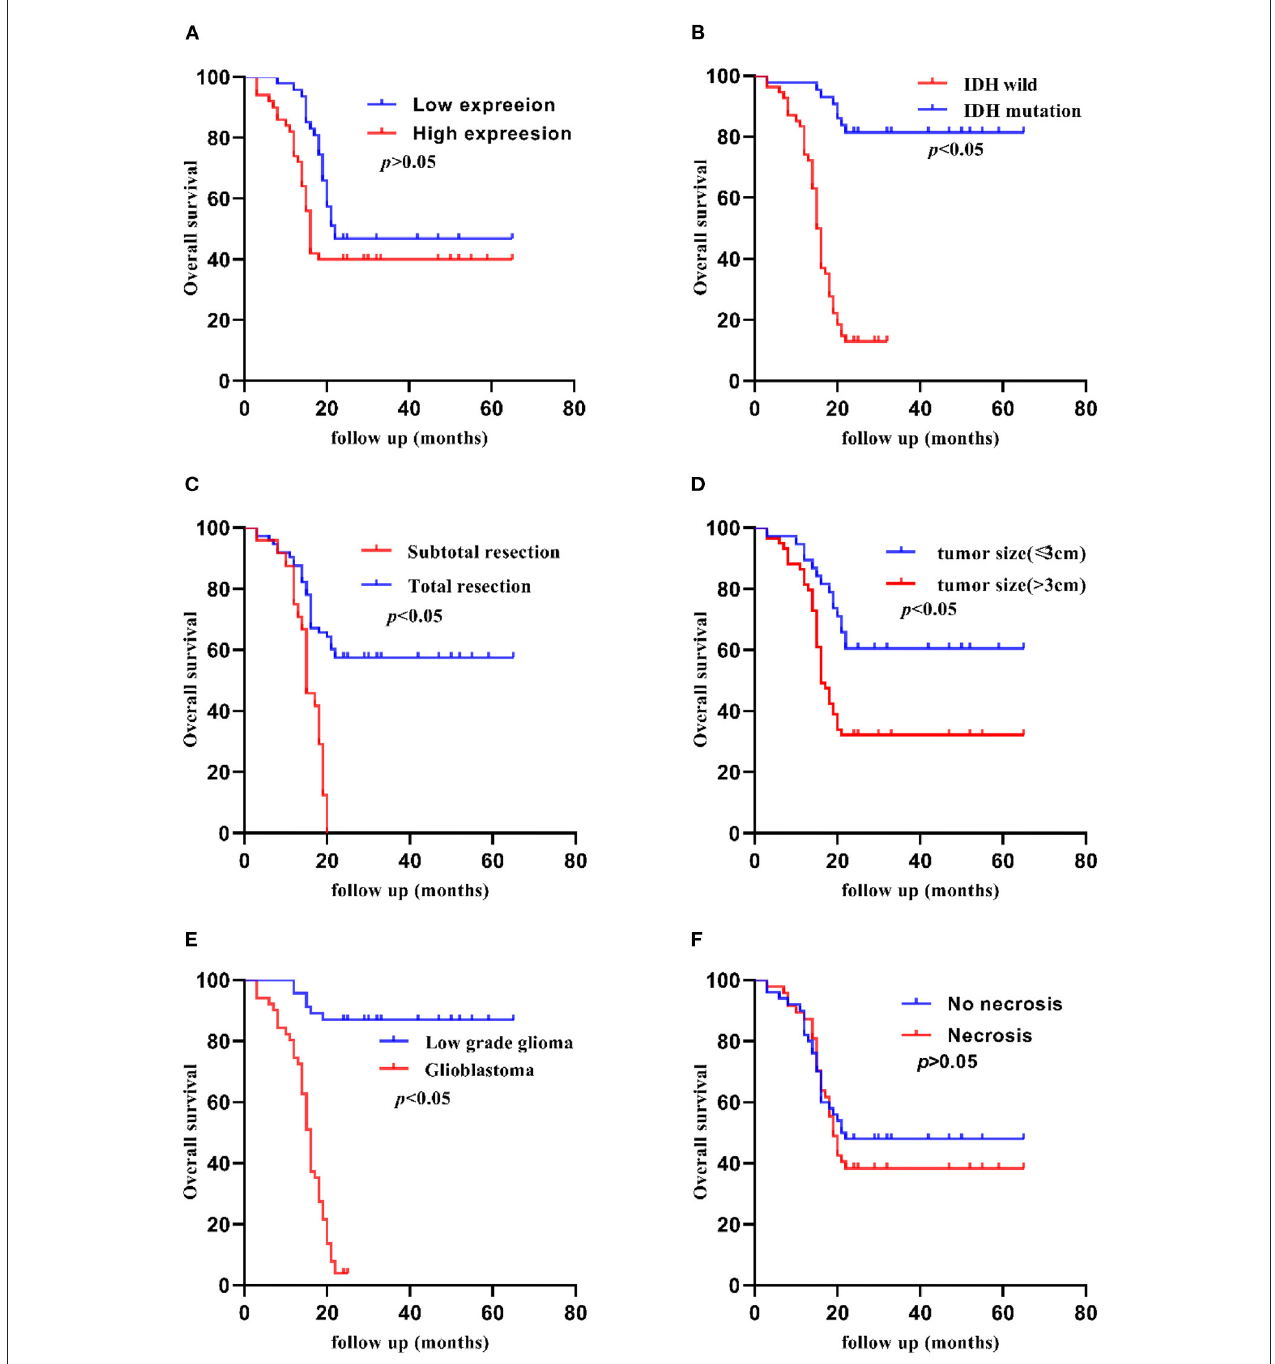
FIGURE 3 | Kaplan-Meier 2-year OS curves of patients with glioma according to clinicopathological features. (A) Patients with higher TCF7L2 expression showed no significant differences compared with those with a lower expression ( p = 0.008). (B) Patients with IDH wild-type showed worse OS compared with those with an IDH mutation ( p = 0.001). (C) Patients who had a subtotal resection showed worse OS compared with those who had a total resection ( p = 0.001). (D) Patients with a larger tumor size ( > 3cm) showed worse OS compared with those with a small tumor size ( ≤ 3cm) ( p = 0.003). (E) Glioblastoma patients showed worse OS compared with low-grade patients ( p = 0.001). (F) Patients with necrosis showed no significant differences compared with those with no necrosis ( p = 0.486).